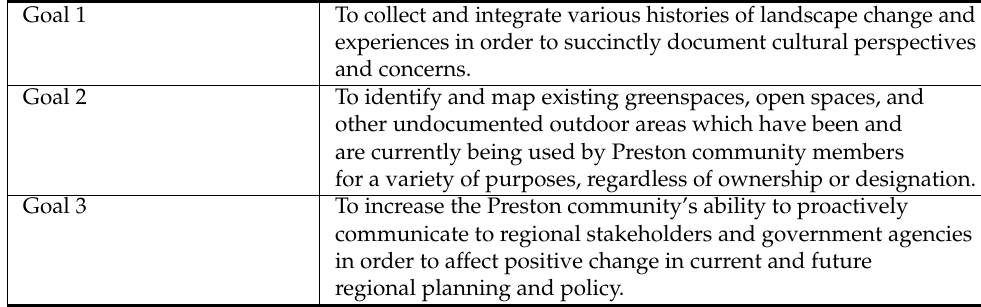
Table 1. Preston community project goals.